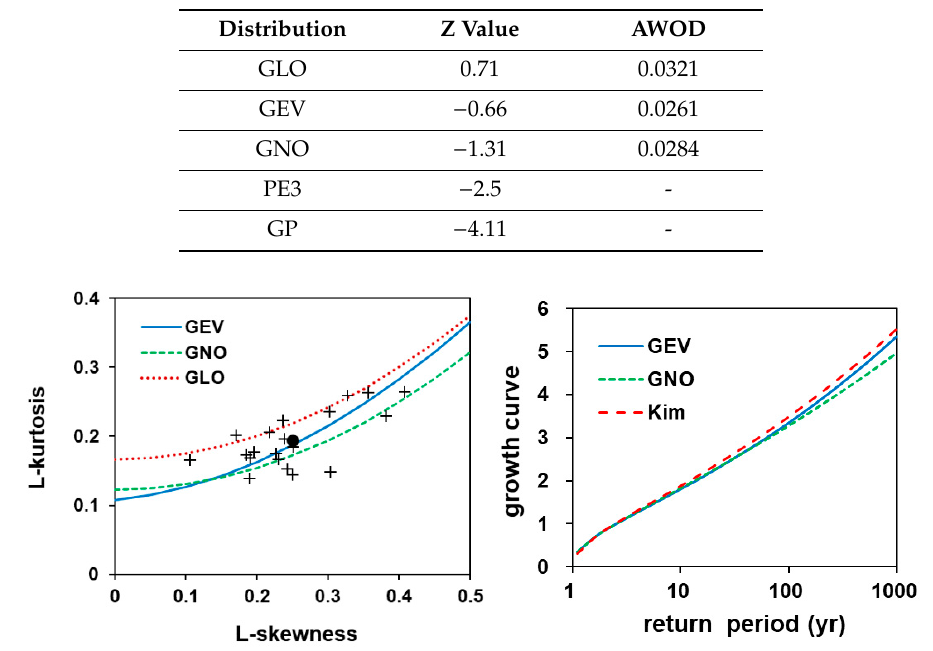
Figure 3. L-moment ratio diagram ( left ) and the comparison of regional growth curves ( right ). Kim is the result of Kim et al. [17].